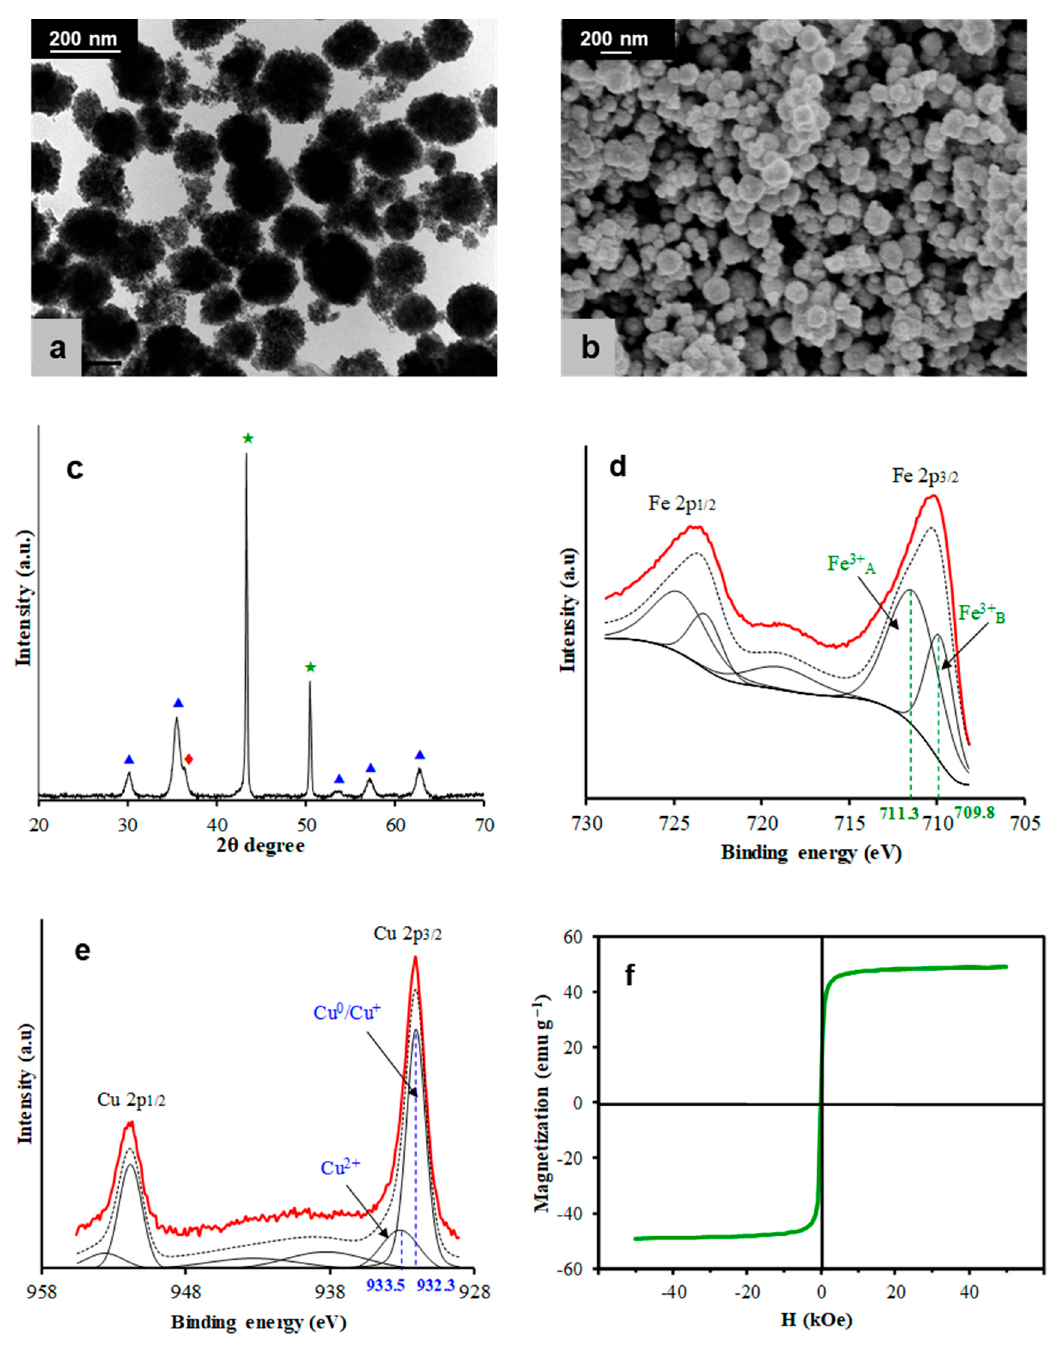
Figure 1. ( a ) TEM and ( b ) SEM micrographs of copper ferrite nanospheres (CFNS). ( c ) XRD patterns of the CFNS catalyst: ( ▲ ) cubic spinel; ( ★ ) copper; ( ◆ ) cuprite. ( d ) and ( e ) XPS profiles of the Fe2p and Cu2p regions, respectively, and ( f ) magnetization versus the applied magnetic field.